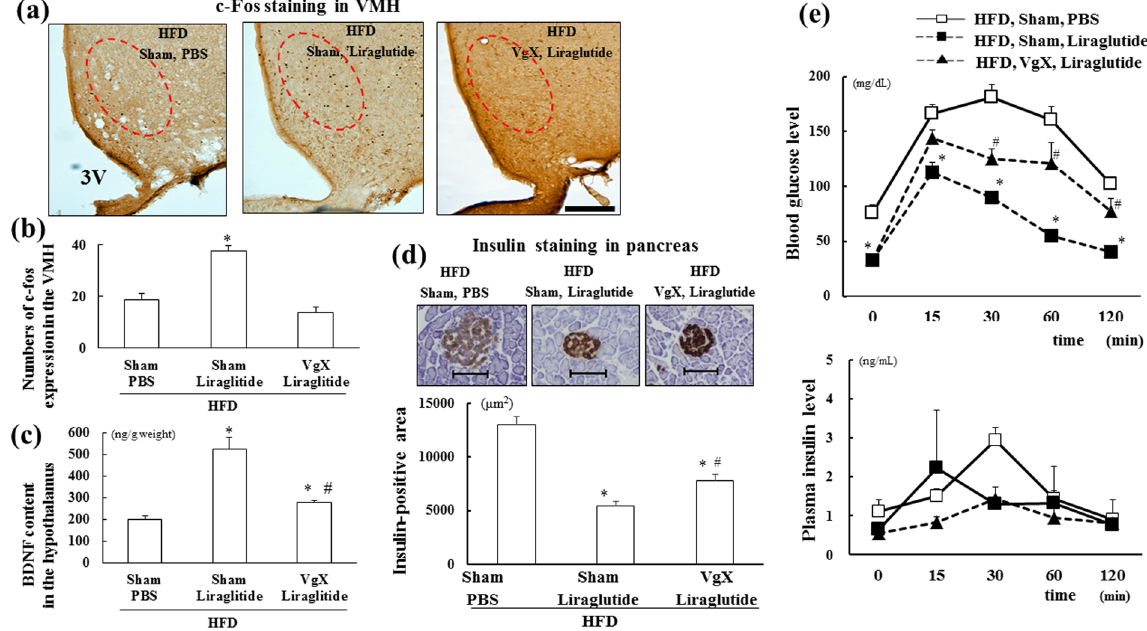
Figure 5. Chronic administration of liraglutide increases c-fos expression and BDNF content in the hypothalamus, restores β -cell mass and improves glucose metabolism through hepatic afferent nerves. ( a ) Representative c-fos staining performed on brain sections derived from each group. Red circle indicates the VMH area in the hypothalamus. 3 V; third ventricle. Scale bar = 100 μ m. ( b and c ) Quantification of c-fos expression in the VMH ( b ) and BDNF content in the hypothalamus ( c ) of each group (n = 6). ( d ) Representative insulin staining performed with pancreas sections and quantification of the insulin-positive area from each group (n = 6). Scale bar = 100 μ m. ( e ) Blood glucose (upper) and plasma insulin (lower) levels during the glucose tolerance tests in each group (n = 6). * p < 0.05 vs. HFD (Sham, PBS) group, # p < 0.05 vs. HFD (Sham, Liraglutide) group. Treatments: PBS; intraperitoneal administration of PBS, Liraglutide; intraperitoneal administration of liraglutide, Sham; sham operation, VgX; hepatic afferent vagotomy. HFD; fed with high-fat